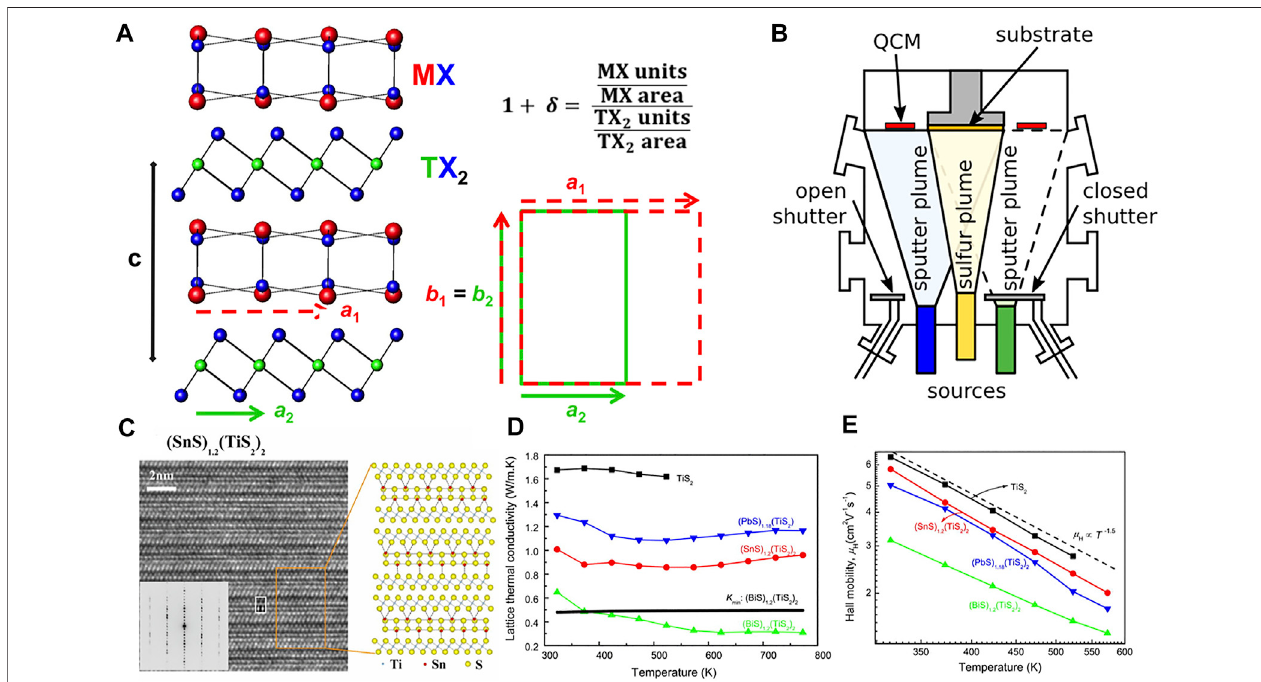
FIGURE 6 | (A) Structural summary of mis fi t layer compounds. General Superlattice structure (left) with in-plane lattice depiction (bottom right) and calculation of mis fi tparameter basedondifferenceinin-planepackingdensity (top right).Reprinted withpermissionfromref.[109],Copyright2015,MultidisciplinaryDigitalPublishing Institute. (B) Side view of sputter chamber geometry used to deposit precursor fi lms. Orthogonal shuttered sputter cathodes (green and blue) and a non-shuttered elemental sulfur cell are used as atom sources; rates are monitored by quartz crystal microbalances (QCMs) (red squares). Reprinted with permission from Ref. [116], Copyright 2020, American Chemical Society. (C) Transmission electron microscope image (left), and simulated crystal structure (right) of (SnS) 1.2 (TiS 2 ) 2 along the [100] zone axis. The electron diffraction patterns are also shown in the inset of HRTEM image. (D) In-plane lattice thermal conductivity and (E) Hall mobility of TiS 2 (PbS) 1.18 (TiS 2 ) 2 (SnS) 1.2 (TiS 2 ) 2 ,and(BiS) 1.2 (TiS 2 ) 2